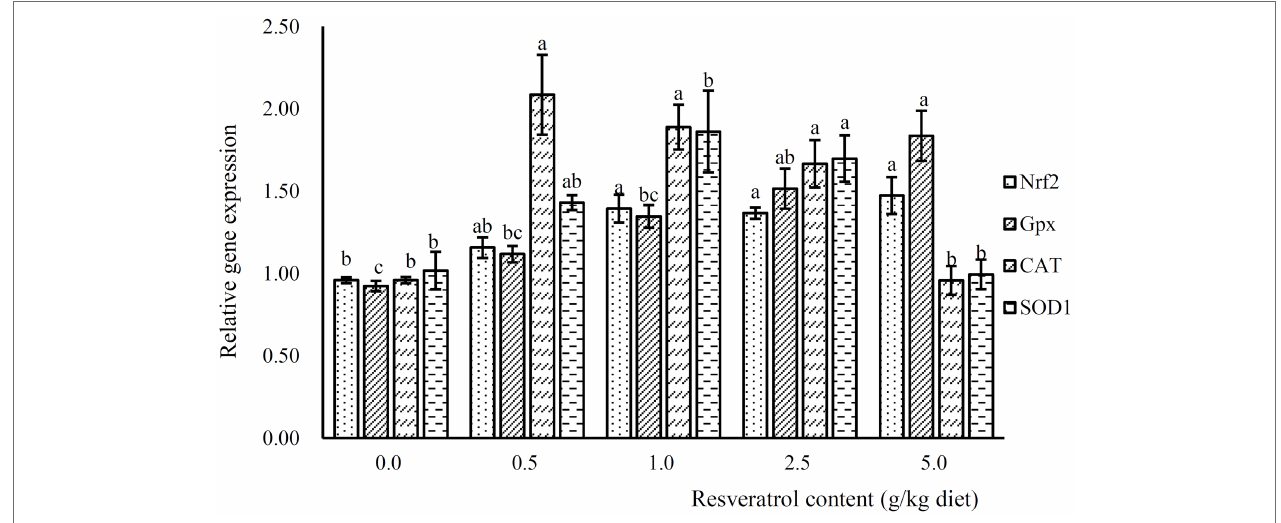
FIGURE 6 | The expression of antioxidant related genes, Nrf2, Gpx, SOD1 and CAT, in response to graded levels of dietary RSV in largemouth bass for 10 weeks. Values (means ± standard error of the mean, SEM) in bars that have the same letter are not significantly different ( p > 0.05; Duncan’s test) among treatments ( N =